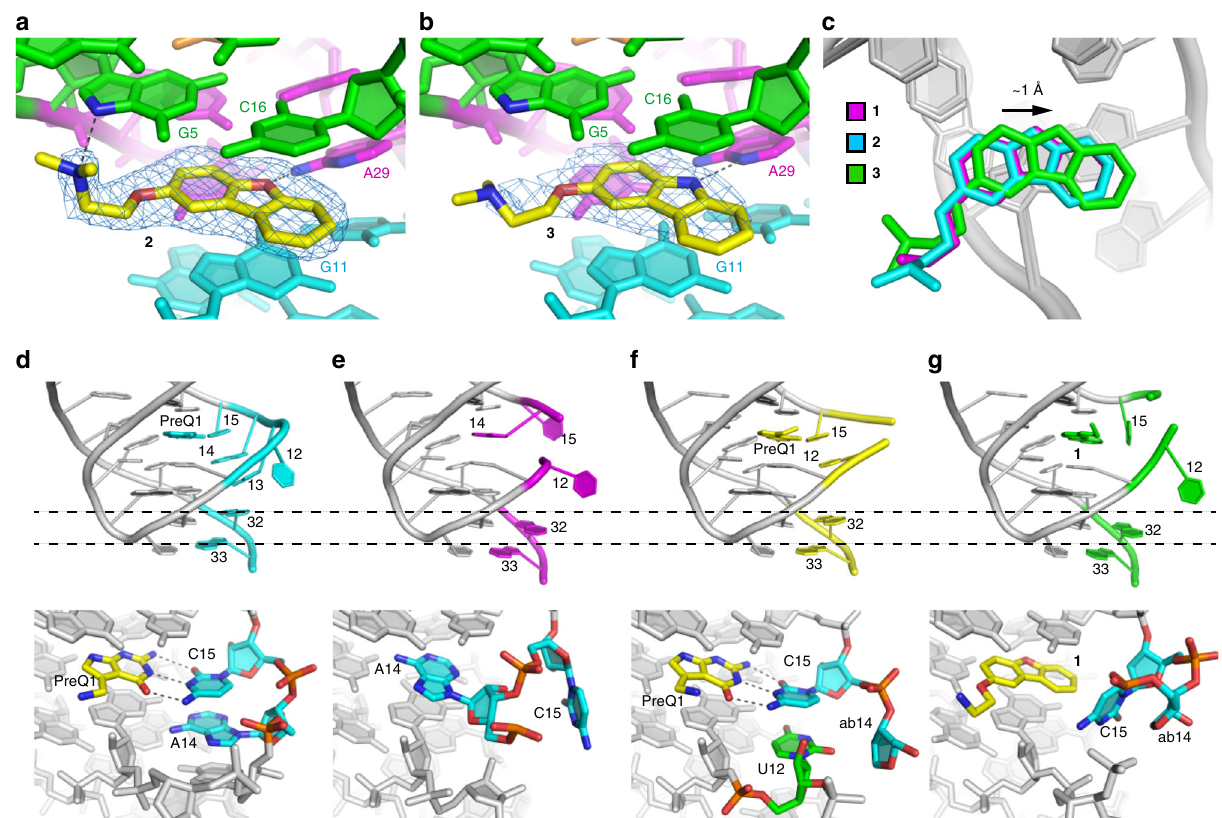
Fig. 8 Structural analysis of the bound Tt PreQ 1 aptamers. a Ligand-binding site of the ab13_14- 2 co-crystal structure, superimposed on the | F o | − | F c | electron-density map calculated before addition of the ligand to the crystallographic model (blue mesh, 3.0 σ contour). Hydrogen bonds are indicated as dotted lines. b Ligand-binding site of the ab13_14_15- 3 co-crystal structure. The | F o | − | F c | electron density map for the compound is colored blue and contoured at 3.0 σ . c Comparison of binding modes of 1 (magenta), 2 (cyan), and 3 (green). Ligand-binding site and continuous base stack of the aptamer domains of the d WT-PreQ 1 , e WT free, f ab13_14-PreQ 1 , and g ab13_14- 1 forms. (Upper) Cartoon representations with ligands and key nucleotides labeled and colored cyan, magenta, yellow, and green in the WT-PreQ 1 , WT free, ab13_14-PreQ 1 , and ab13_14- 1 forms, respectively. To compare the locations of A32 and G33 among these structures, dashed lines are indicated. (Lower) Detail of the ligand-binding site. PreQ 1 and 1 are in yellow. Key nucleotides responsible for forming the base stack are colored cyan. U12 in the ab13_14-PreQ 1 structure, which occupies a similar location to A14 in the WT-PreQ 1 structure, is in green. Hydrogen bonds between PreQ 1 and C15 are indicated as dotted